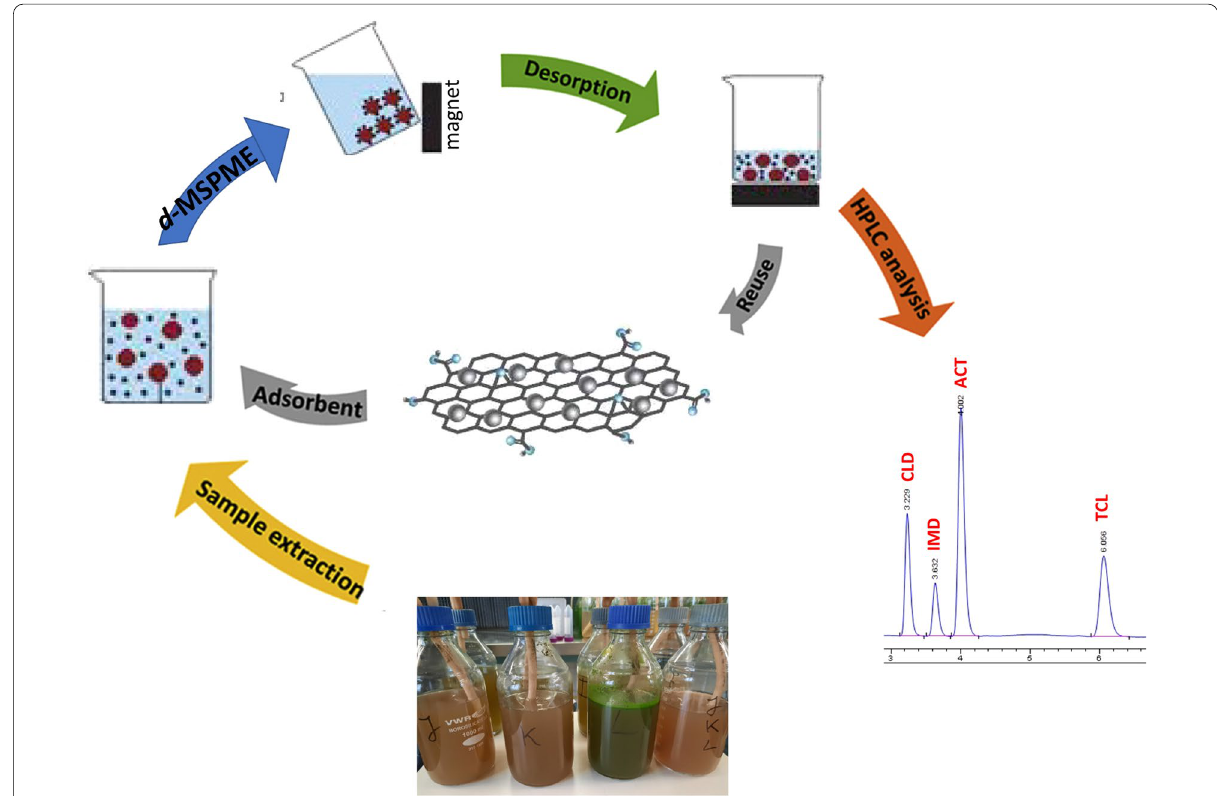
Fig. 1 Schematic diagram summarizing the experimental procedures